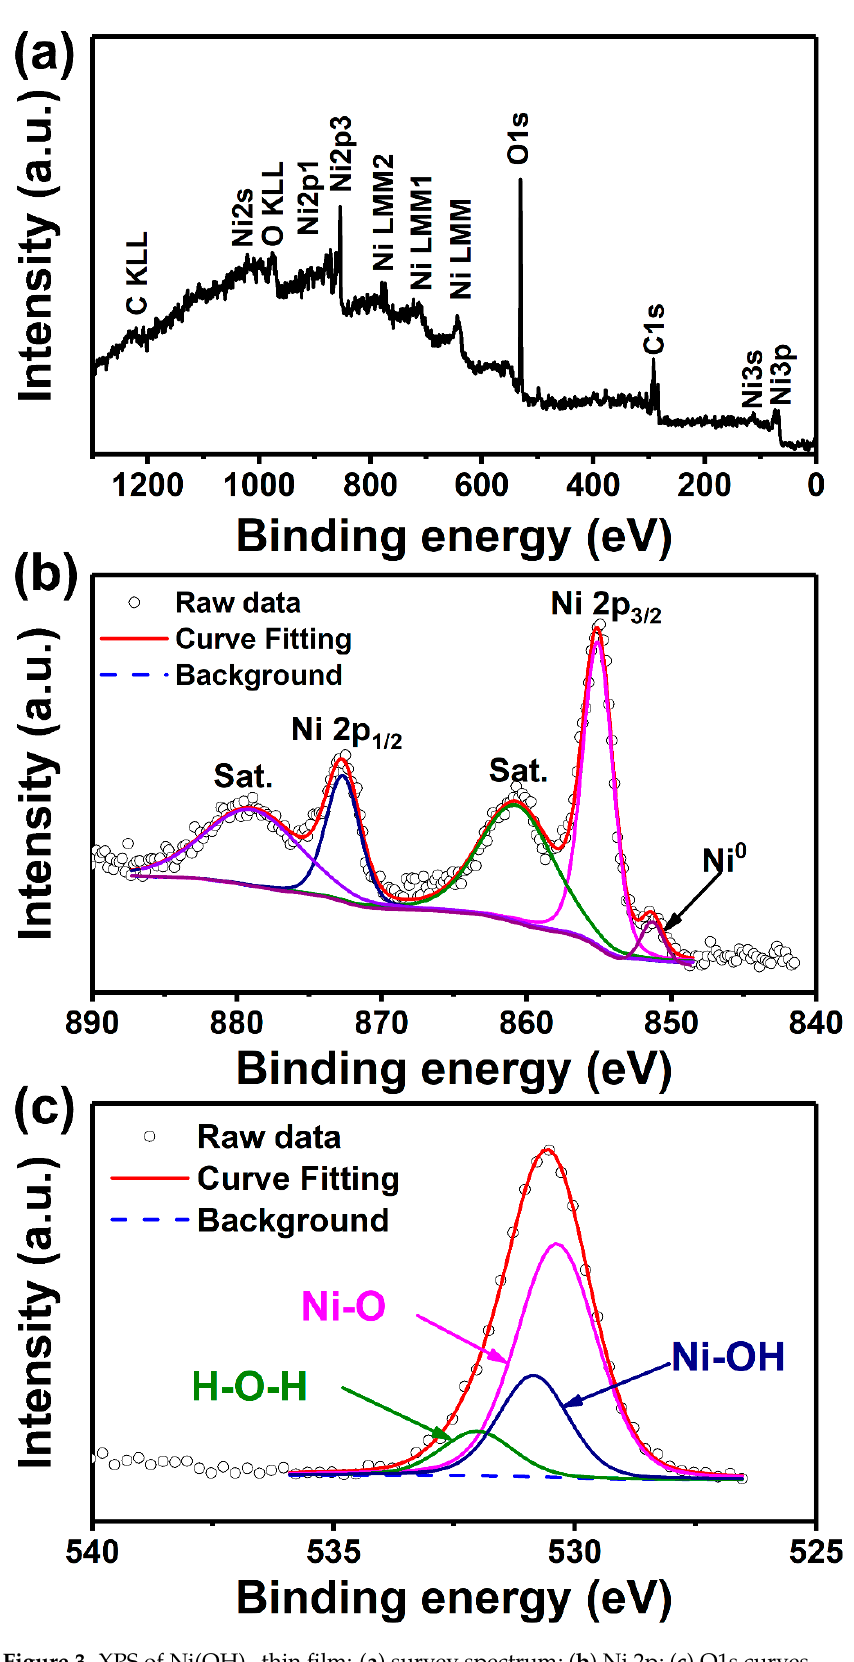
Figure 3. XPS of Ni(OH) 2 thin film: ( a ) survey spectrum; ( b ) Ni 2p; ( c ) O1s curves.